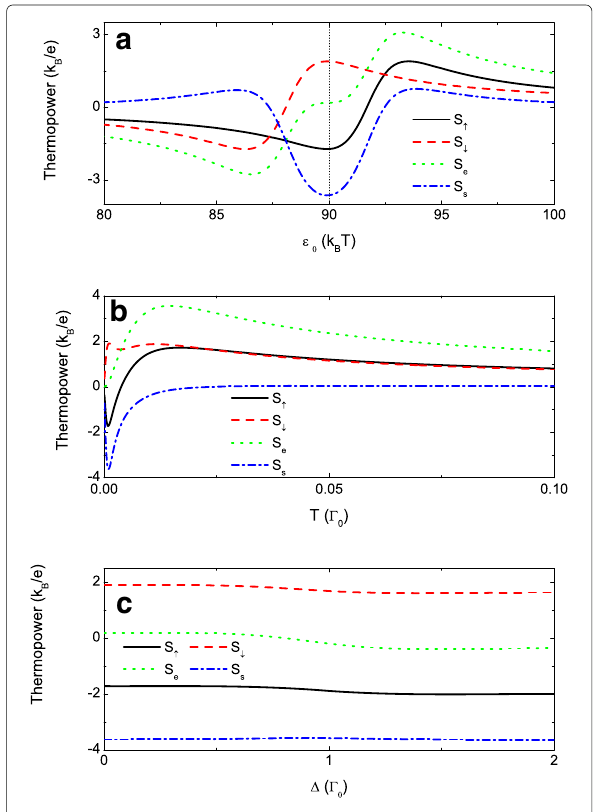
Fig.6 Quantum regulations of the thermopowers. The thermopowers varying with the dot level in a , the temperature in b and the level detuning in c . Other parameters are p = 0.02, t 0 = 1, and t c = 0.3. The dot level in b and c is chosen as ε 0 = 0.09 (cid:8) 0 . The level detuning (cid:5) = 0 in a and b , and the temperature is T = 0.001 in a and